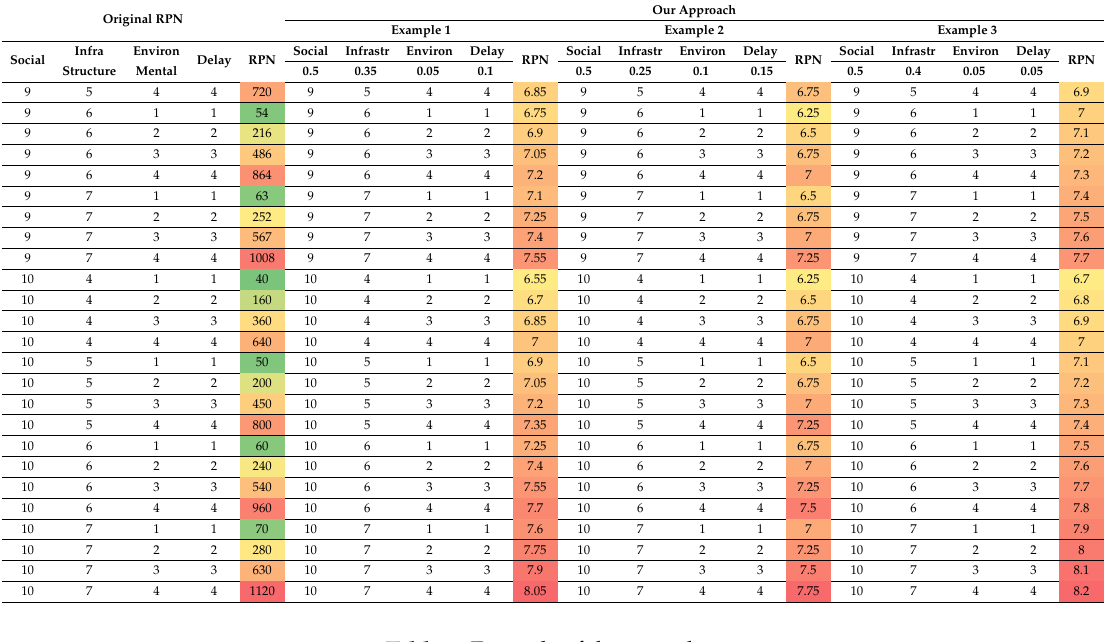
Table 8. Example of three results.